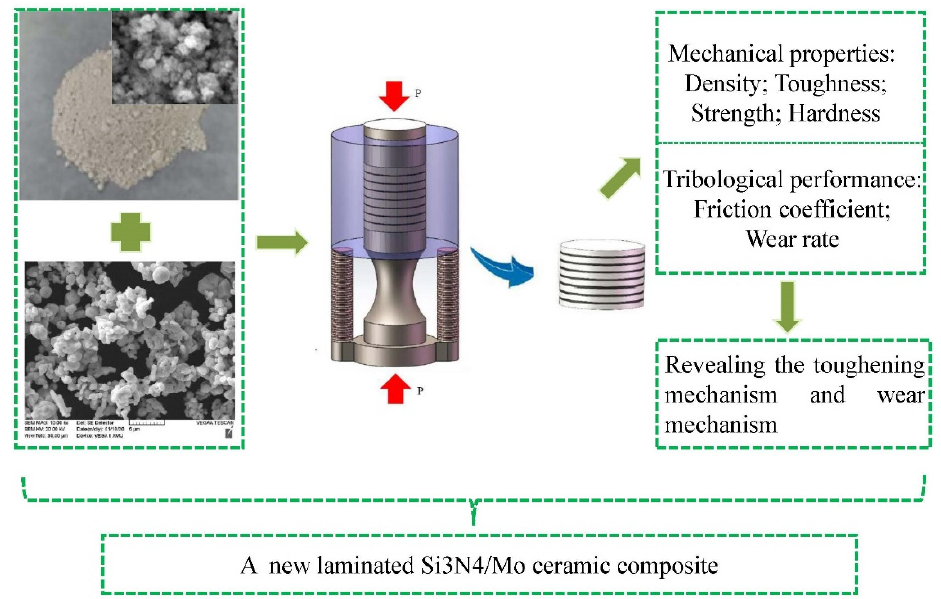
Figure 3. Roadmap of this research work.